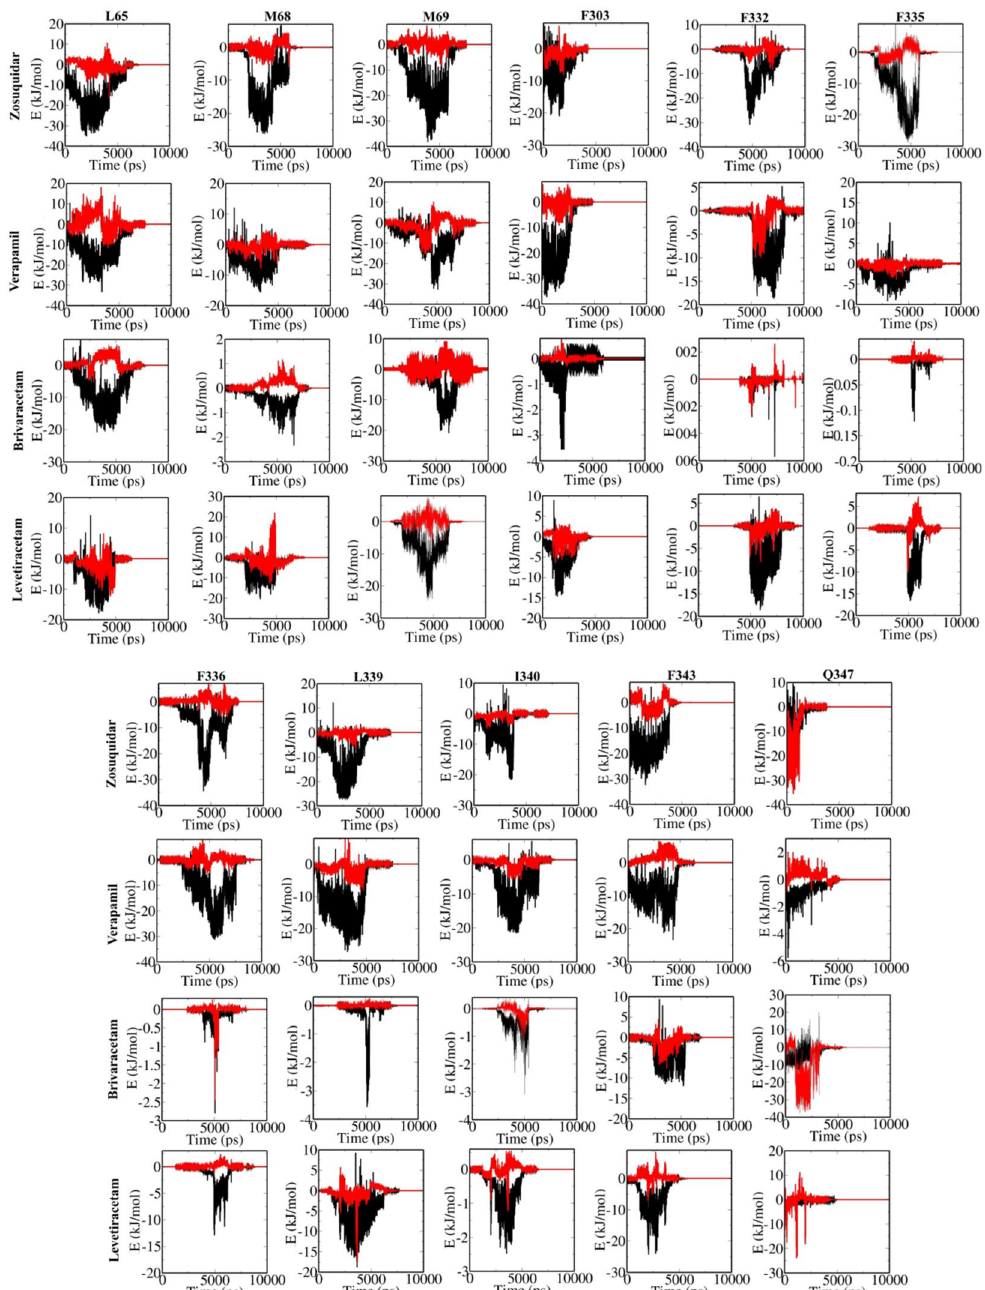
Figure 4. Energy profiles for the key lining residues of the P-gp transport channel in the interaction with studied drugs, showing the van der Waals (black) and electrostatic (red) energy